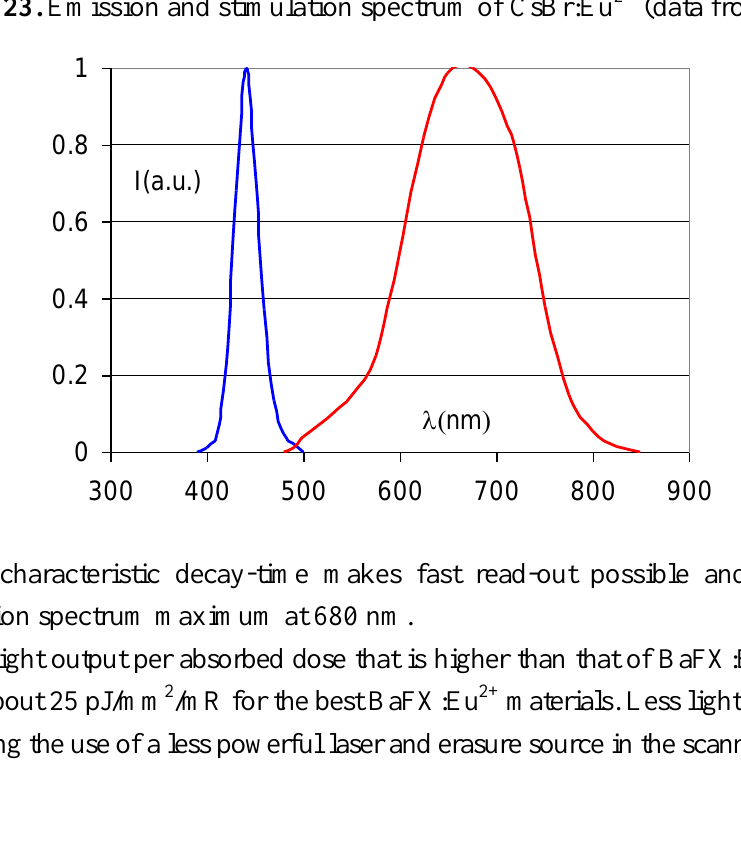
Figure 23. Emission and stimulation spectrum of CsBr:Eu 2+ (data from